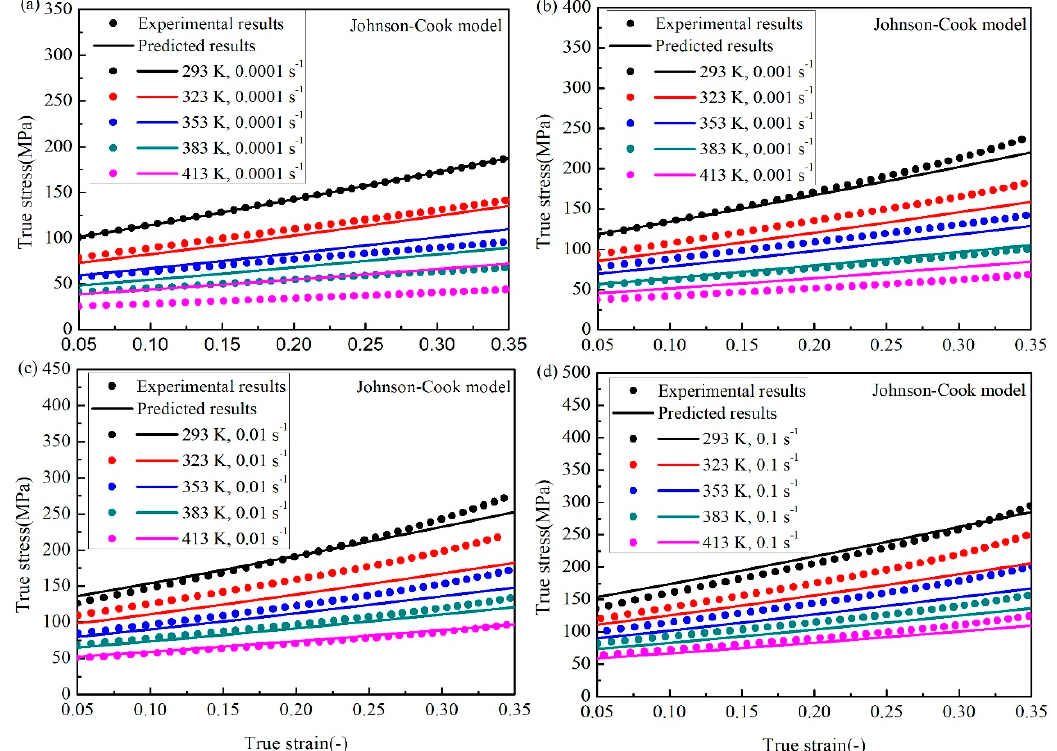
Figure 6. Comparison between the experimental data and the predicted values by the J–C model at the strain rate of ( a ) 0.0001 s − 1 , ( b ) 0.001 s − 1 , ( c ) 0.01 s − 1 , and ( d ) 0.1 s − 1 .